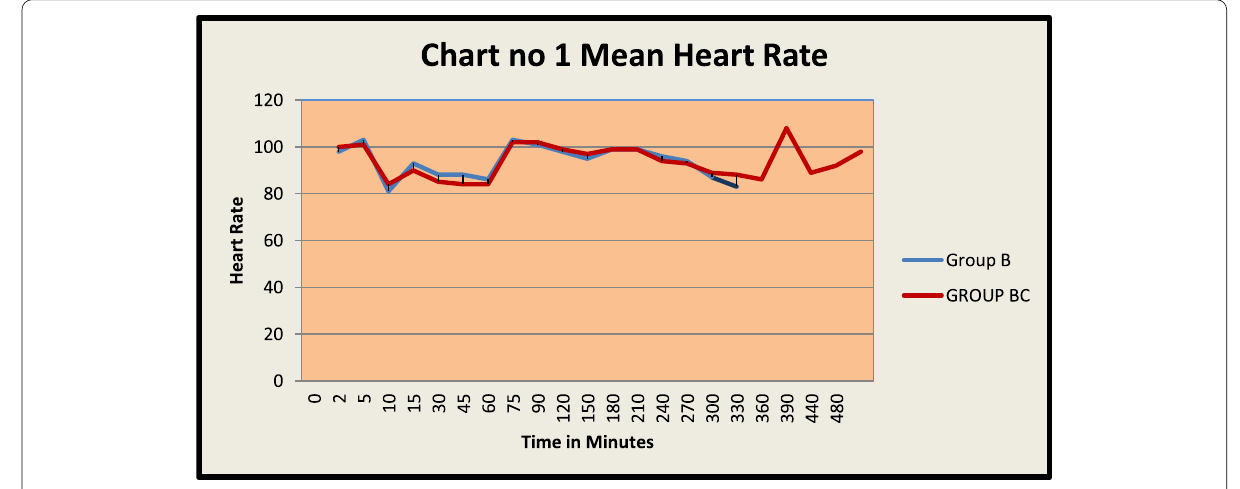
Fig. 1 Mean heart